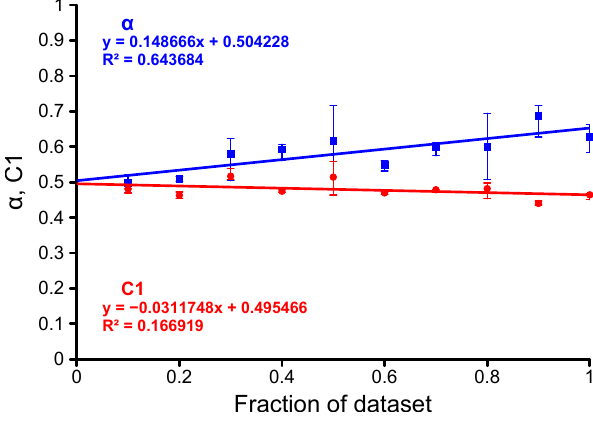
Fig. 4a. K(q) vs. q for all sections of the Medicine Hat snowfall. Each section is one-tenth of the entire time series. The points cor- respond to empirical values; the lines represent the universal multi- scaling relationships computed for each section.